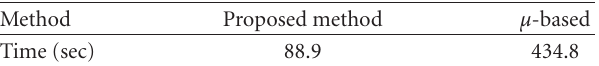
Table 1: The average computation time needed for bound calcula- tion.